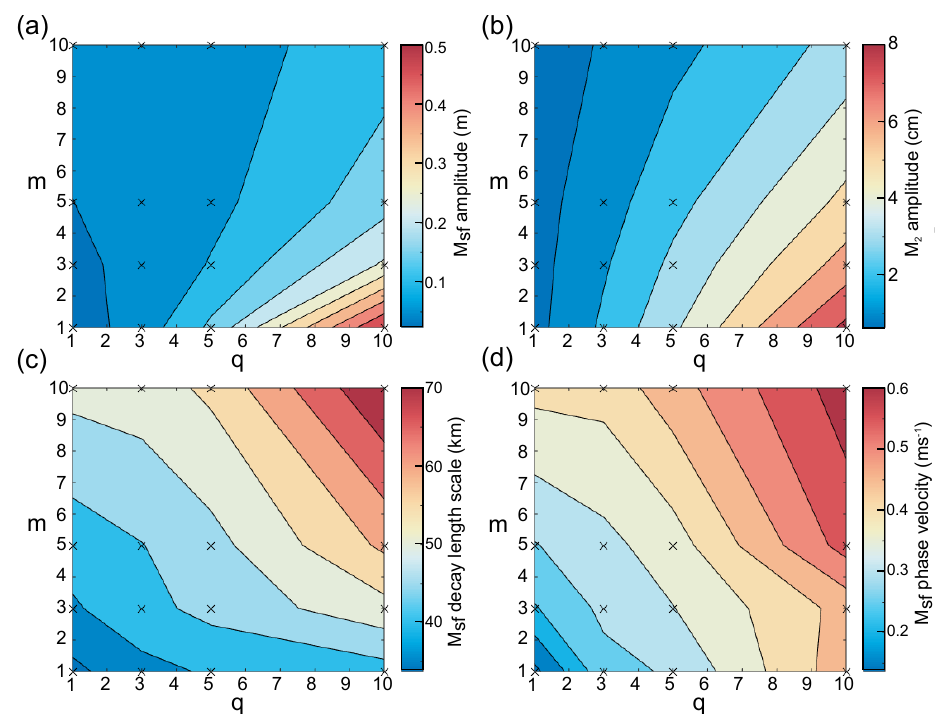
Figure 8. Response of M sf amplitude (a) , M 2 amplitude (b) , M sf decay length scale (c) and M sf phase velocity (d) to choice of stress exponent ( m ) and hydrological exponent ( q ). Crosses indicate model simulations. M sf and M 2 amplitudes were taken at 10km upstream from the grounding